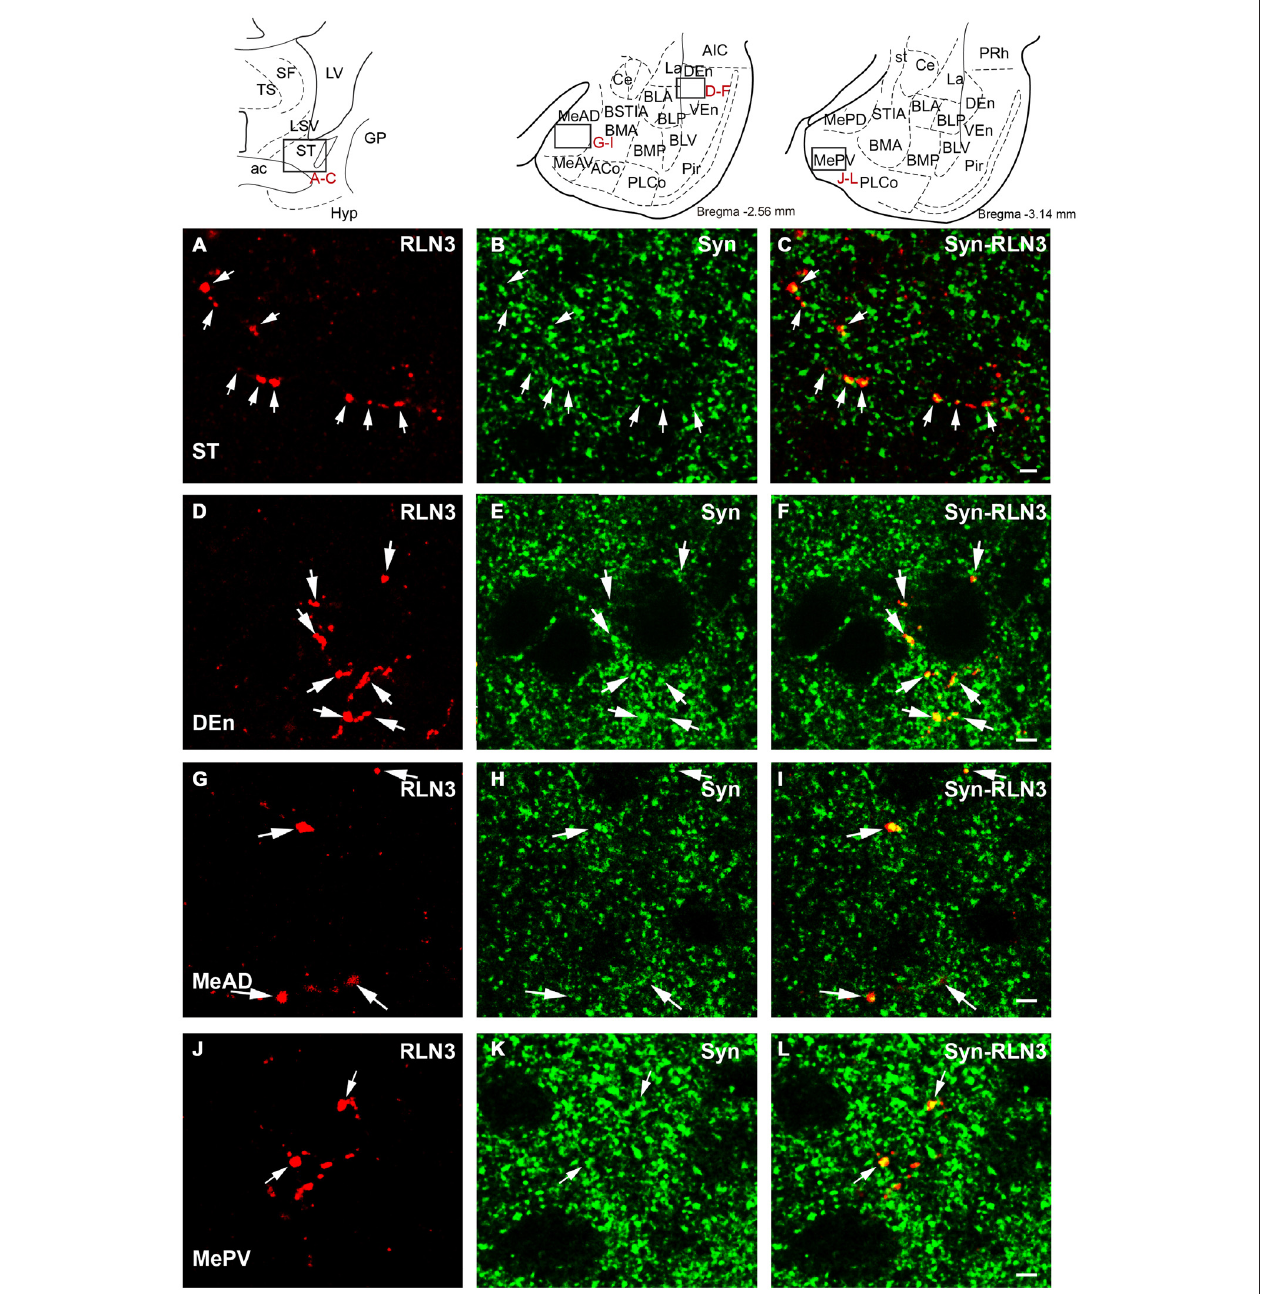
FIGURE 12 | Confocal images revealing the colocalization of relaxin-3 (red) and synaptophysin (green) in the framed areas of uppermost schematic images. Single 0.5 µ m sections displaying the localization (arrows) of relaxin-3 (A) synaptophysin (B) and a merged image (C) in the medial aspect of the ST. Single 0.5 µ m sections displaying the localization (arrows) of relaxin-3 (D) synaptophysin (E) and a merged image (F) in the endopiriform nucleus. Single 0.5 µ m section displaying localization (arrows) of relaxin-3 (G) synaptophysin (H) and a merged image (I) in the medial amygdala (anterior dorsal nucleus). Single 0.5 µ m section displaying the localization (arrows) of relaxin-3 (J) synaptophysin (K) and a merged image (L) in the medial amygdala (posterior ventral nucleus). Calibration bars 5 µ m.